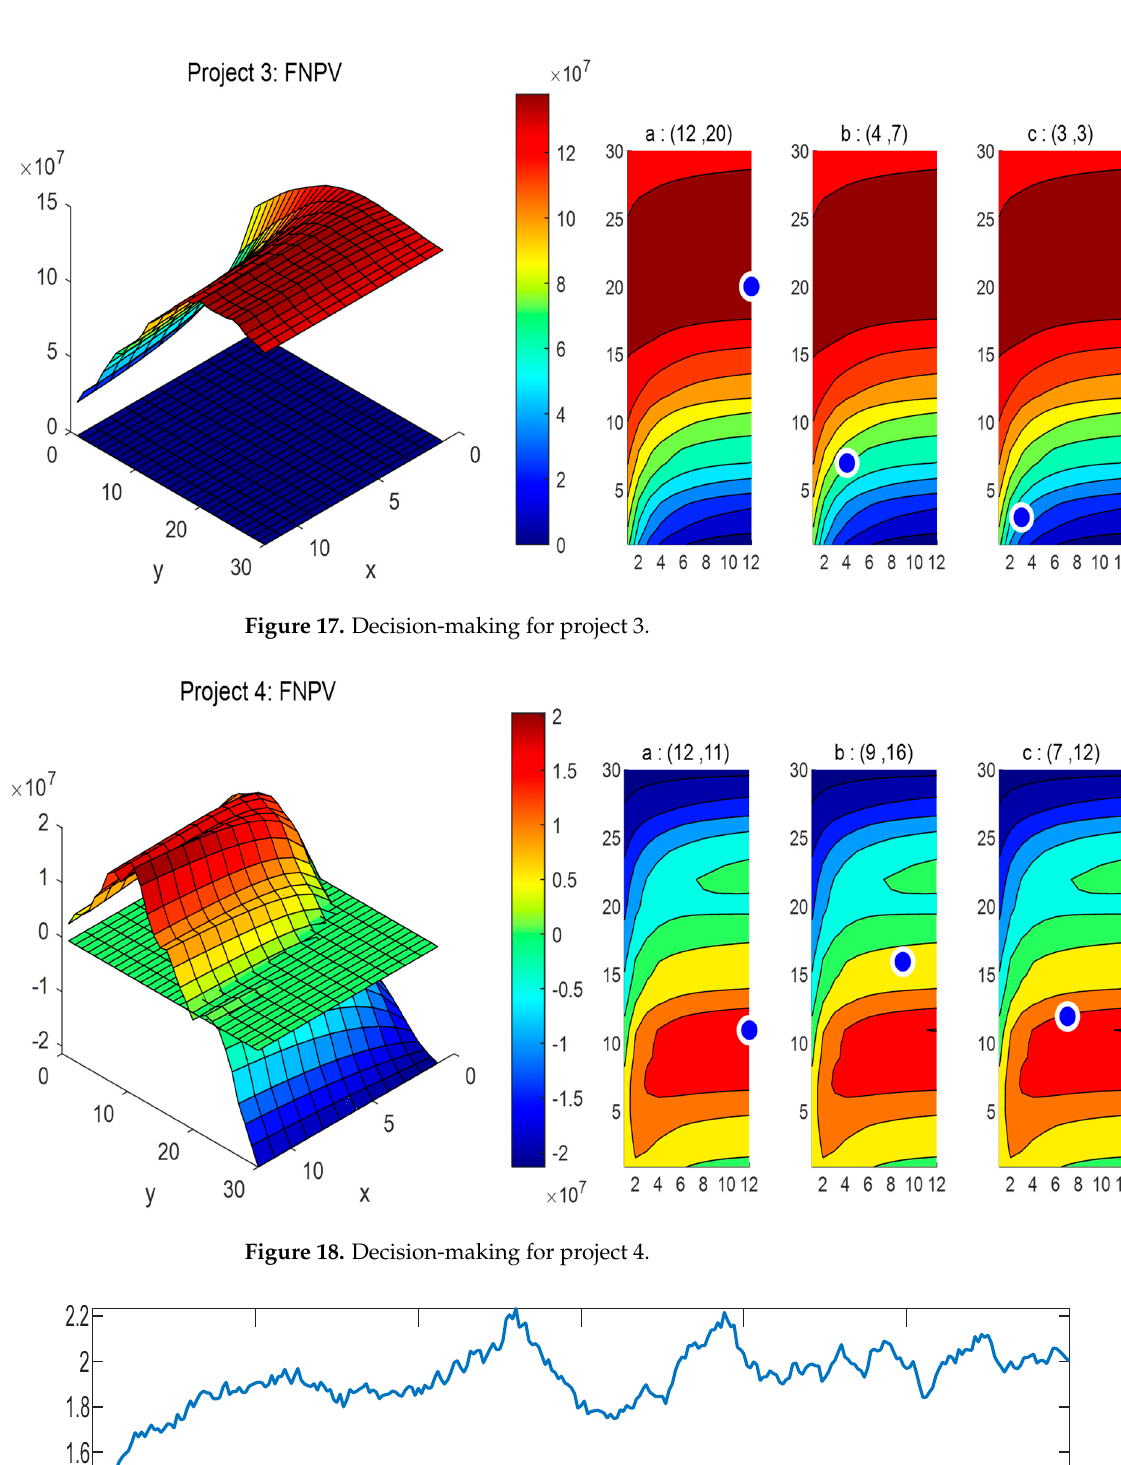
Figure 19. Selected mean value increase scenario of gas prices.